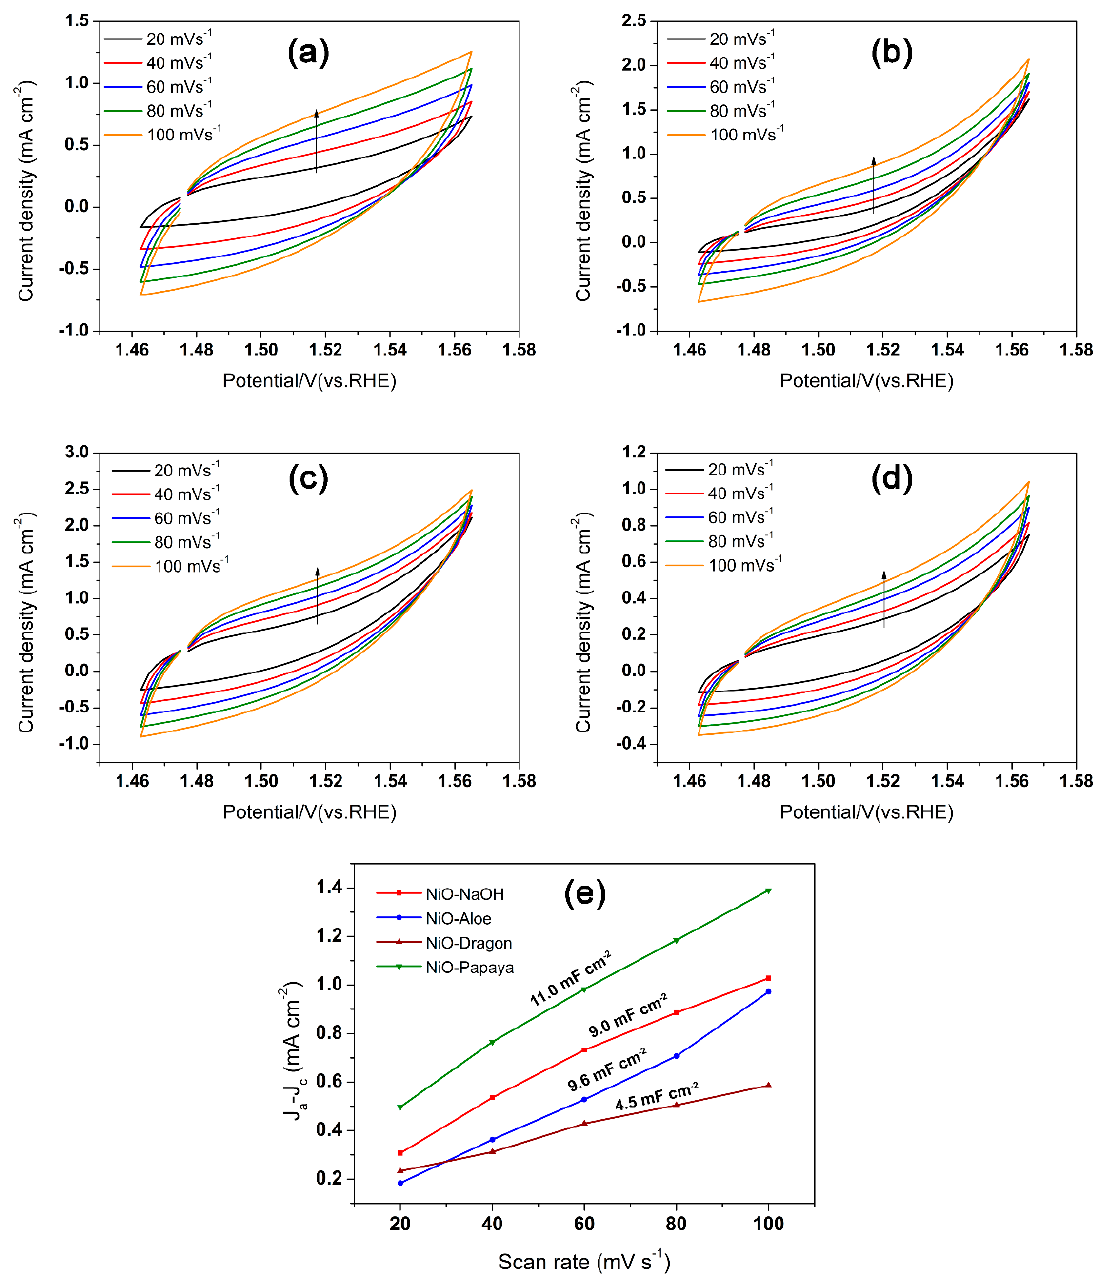
Figure 7. Cyclic voltammogram of ( a ) NaOH-, ( b ) aloe-vera-, ( c ) dragon-fruit- and ( d ) papaya-extract-mediated NiO x nanoparticles and ( e ) linear plot between current density and scan rate.